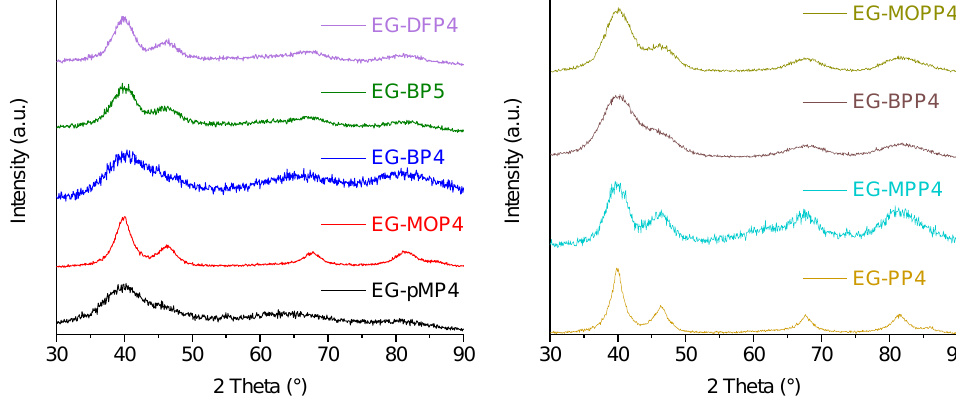
Figure 5. PXRD patterns of (EG/TAAIL)Pt-NPs(cf. Figure 1 and Table 3). All obtained reflexes match the simulation for fcc-Pt and its indexed reflections (cf. Figure 2). Table 3. Summary of crystallite and particle sizes of